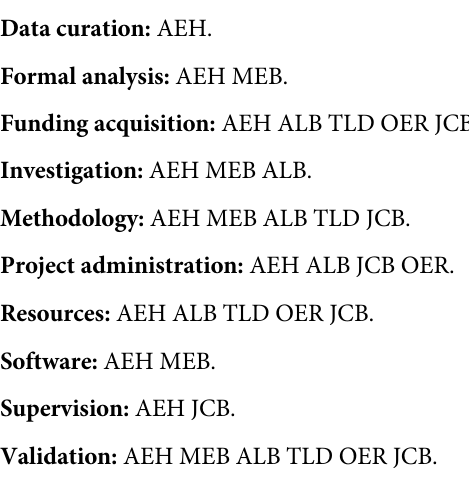
S4 Table. Proportion (%) of annual diurnal movement states (i.e., transitions between flight and stationary motion states) calculated from GPS locations for 9 black vultures and 9 turkey vultures from September 1, 2013, to August 31, 2015. (PDF) S5 Table. Proportion (%) of monthly diurnal movement states calculated from GPS loca- tions for 9 black vultures and 9 turkey vultures from September 1, 2013, to August 31, 2015. (PDF) S6 Table. Proportion (%) of monthly diurnal movement states calculated from GPS loca- tions for 9 black vultures and 9 turkey vultures from September 1, 2013, to August 31, 2015.